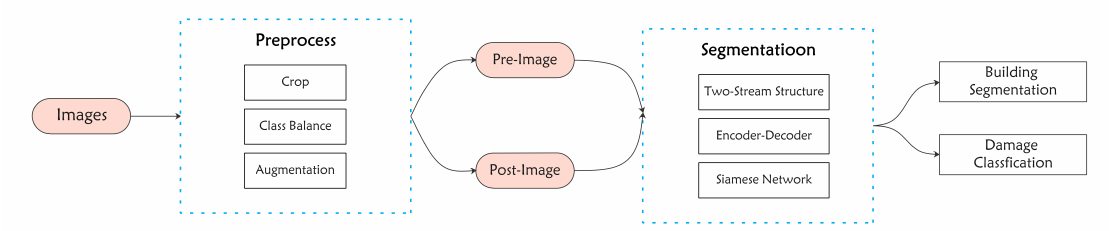
Figure 6. Pixel-level Computation Flow. The images are processed with crop, class balance and augmentation operations. Then, the processed pre-image and post-image are input to the encoder and decoder, and the masks of building segmentation and damage classification are